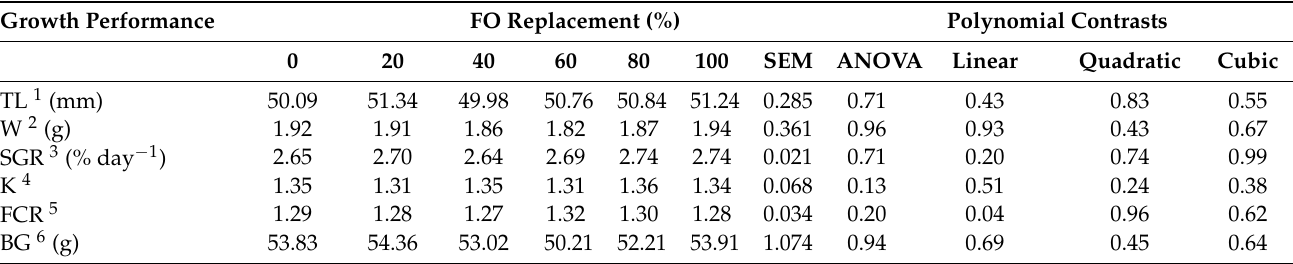
Table 5. Growth performance of juvenile tench fed experimental diets with different replacement of cod liver oil by a blend of vegetable oils over 90